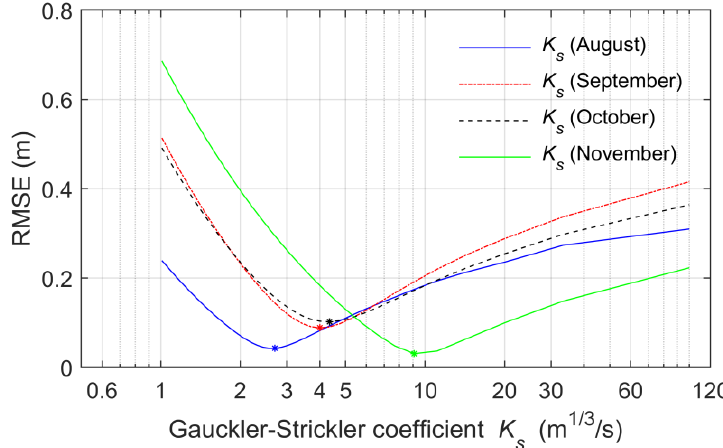
Figure 6. Model performance for di ff erent calibration setups as a function of spatially uniform Gauckler–Strickler K s . Asterisks indicate the optimum values for di ff erent